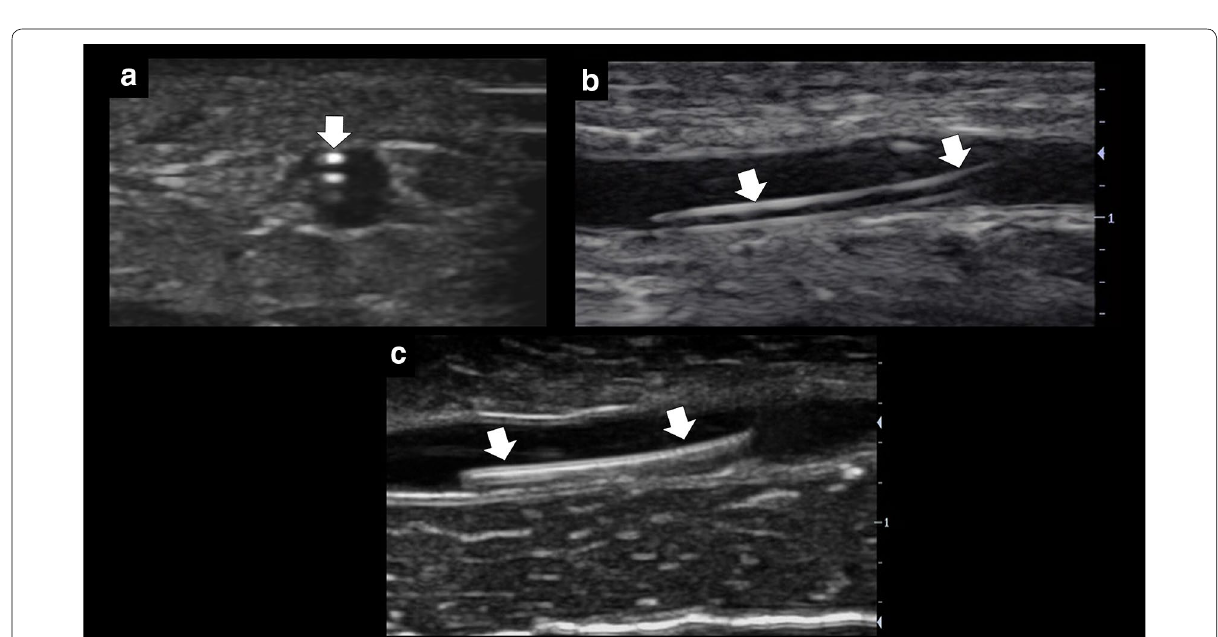
Fig. 9 a , b Demonstration of the catheter (arrows) entering the vein lumen in short ( a ) and long axis ( b ); c demonstration of the guidewire entering the lumen vein (arrows) in the long axis, when using a midline